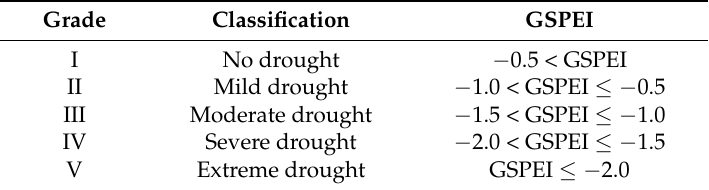
Table 2. Classification of the Gridded Standardized Precipitation Evapotranspiration Index (GSPEI).